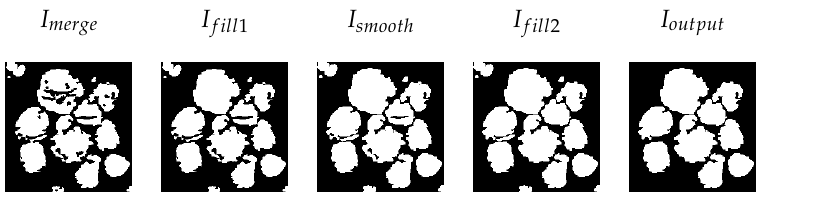
Figure 5. Post-processing of a sample image from dataset.